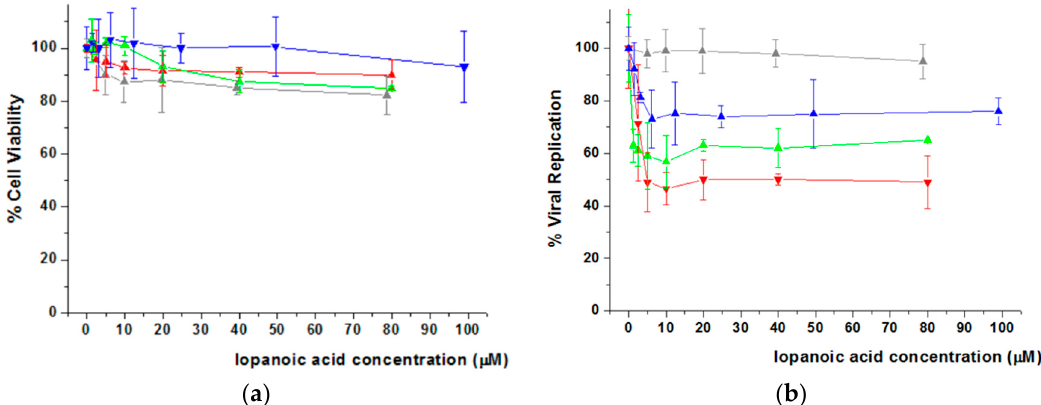
Figure 6. Cell Viability ( a ) and HCV viral replication ( b ) of free and IA-loaded Janus dendrimers in Huh 5-2 cell line. All the data are presented as the average ± standard deviation. Free IA (Grey